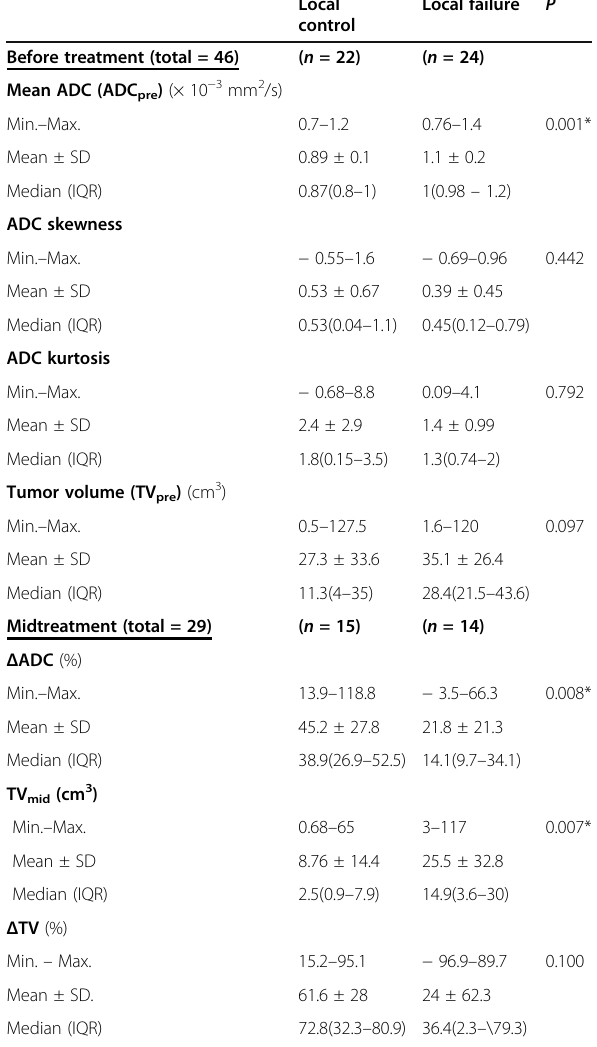
Table 2 Comparison of tumor volume and ADC measurements between local control and local failure patient groups